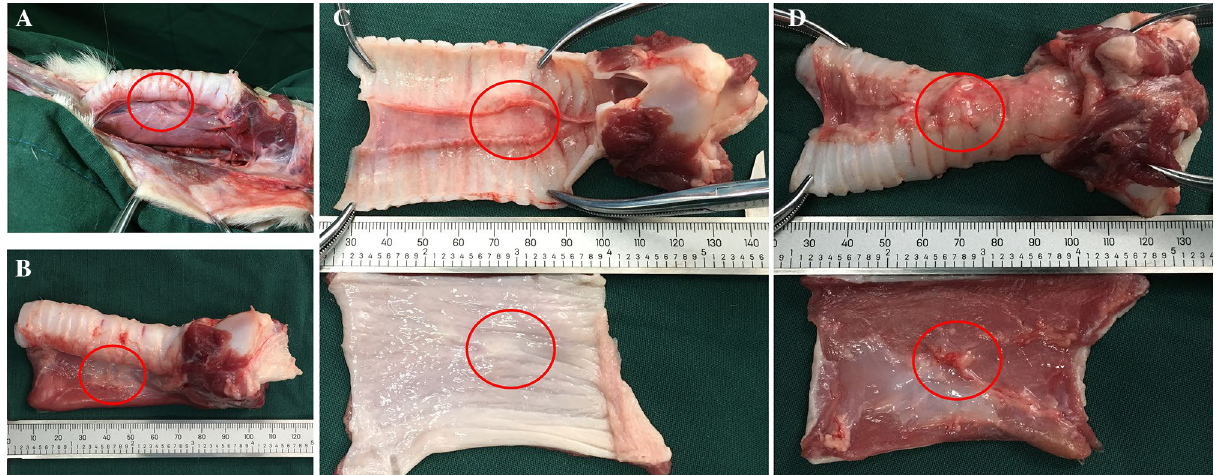
Figure 3. In vitro specimens after TEF repair. ( A ) Esophageal and tracheal space after the removal of pressing magnets. ( B ) Isolated esophagus and trachea specimens. ( C ) The inner side of the tracheal membrane and esophageal mucosa. ( D ) The outer side of the tracheal membrane and esophageal